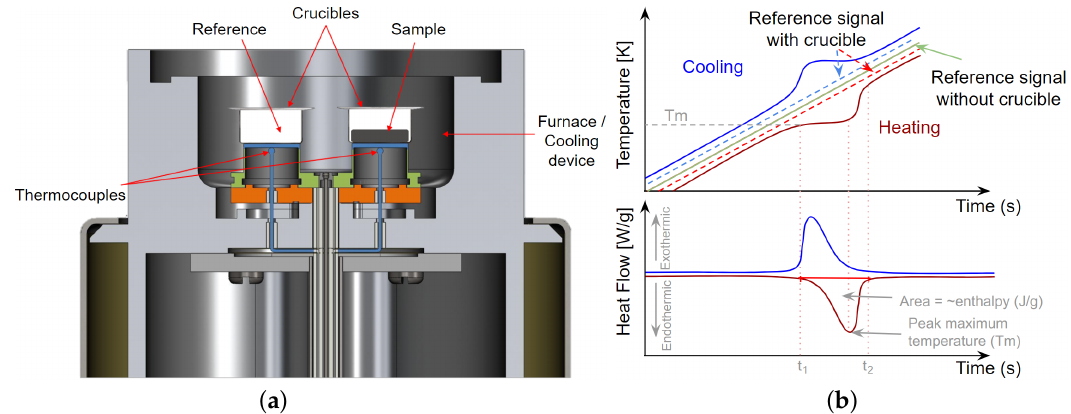
Figure 1. ( a ) Schematic principle of DSC ( b ) Signal generation in a heat flux